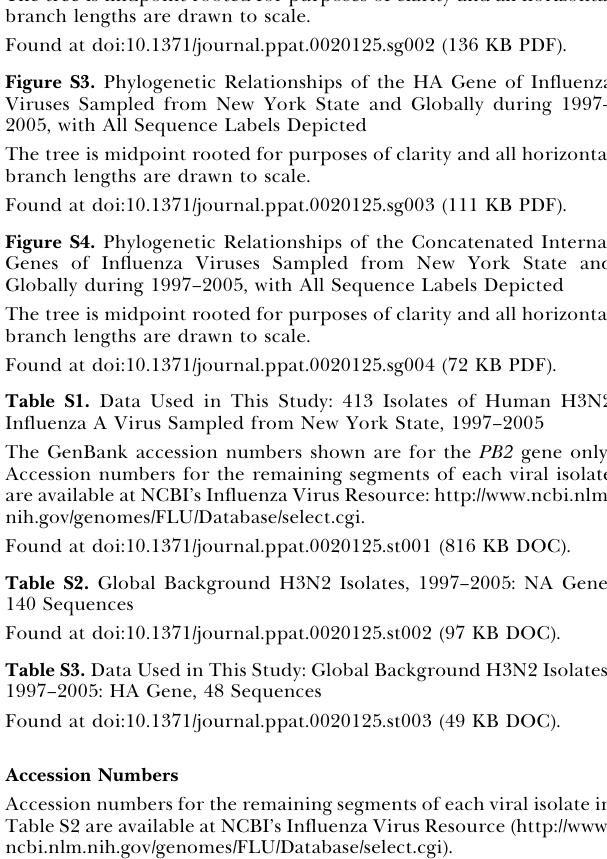
Figure S1. Phylogenetic Relationships of the Concatenated Internal Genes of Influenza Viruses Sampled from New York State and Globally during 1997–2005 Rectangles represent clusters of related New York isolates, with the size of the rectangle reflecting the number of isolates in the clade. Roman numerals indicate separate clades, with seasons colored as in Figure 1. Roman numerals denote the number of separate entries and do not correspond to clade numbers given in Figure 1. Bootstrap values ( . 70%) are shown for key nodes. The tree is midpoint rooted for purposes of clarity, and all horizontal branch lengths are drawn to scale. Figure S2. Phylogenetic Relationships of the NA Gene of Influenza